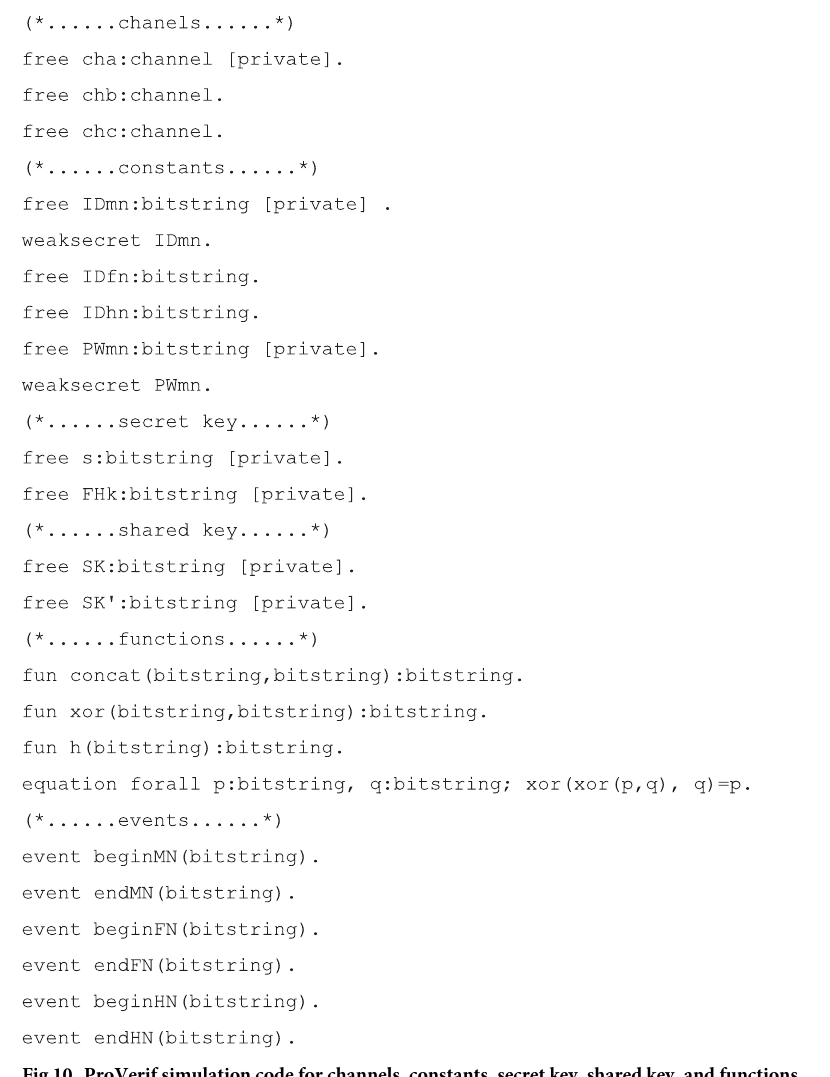
Fig 10. ProVerif simulation code for channels, constants, secret key, shared key, and